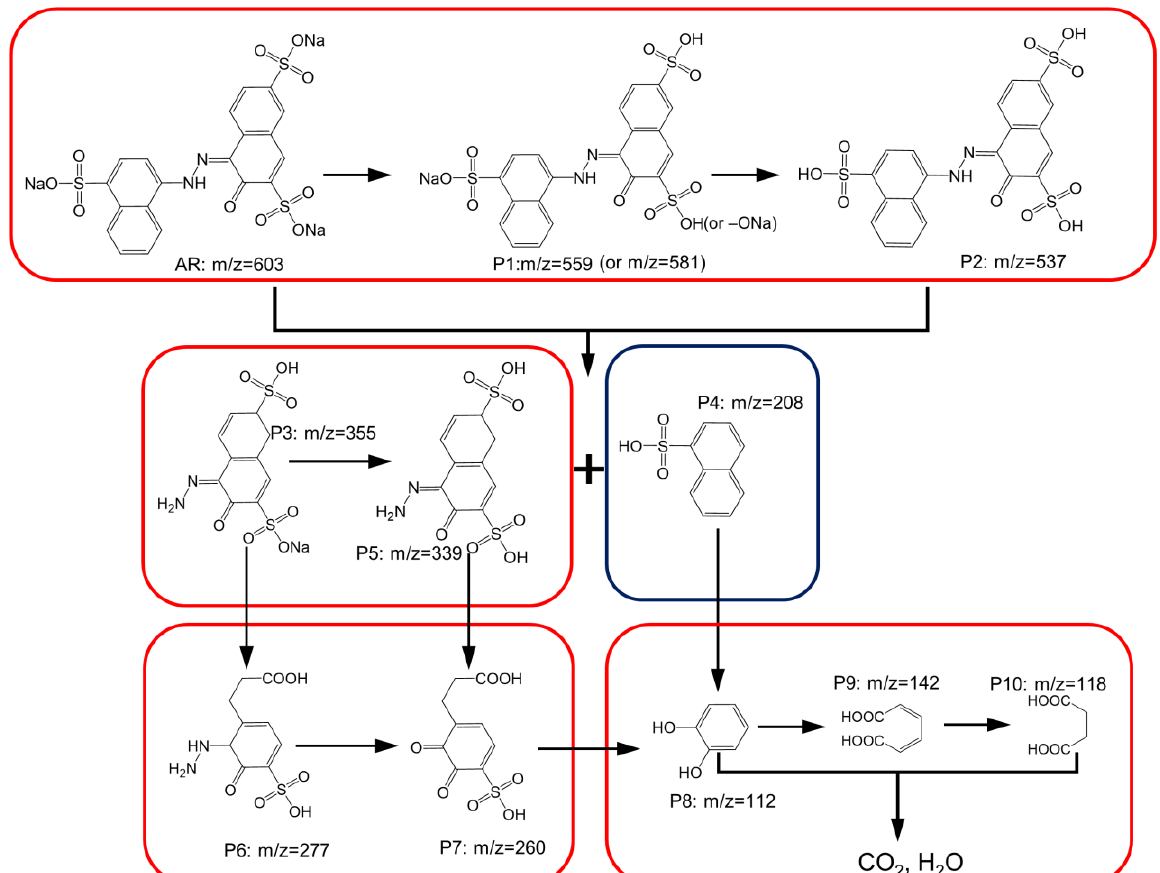
Figure 10. A proposed degradation process of AR by FCCM-activated Oxone based on the detected intermediates.